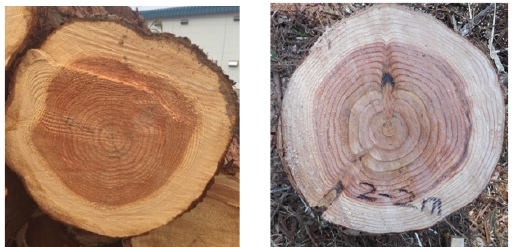
Figure 1. Cross section of